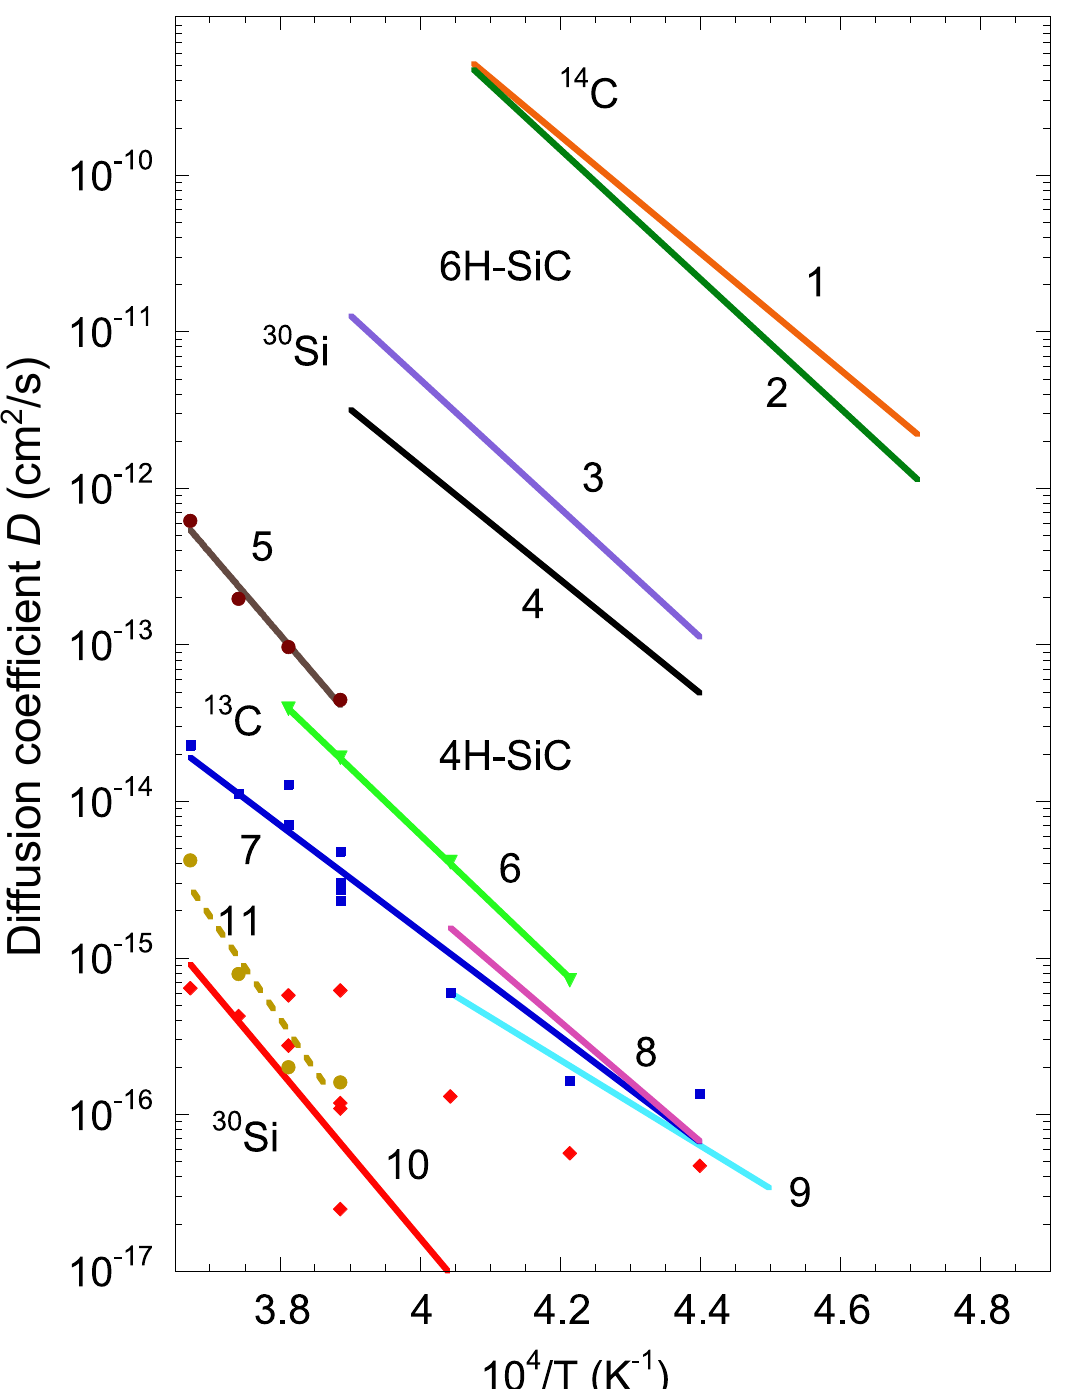
Figure 4. Arrhenius behavior of Si and C diffusivities fitted according to Equation (2), from both this work and the literature. Numbers refer to the present work (No. 5 for 13 C and No. 11 for 30 Si) and Refs. [2,5,6,28,29] (No. 1–4 and No. 6–10), with additional specifiers for the numbering collected in Table 3. Note that results in the same color are related. For example, the dark brown data points and fit refer to 13 C, while the light brown ones refer to 30 Si, both from the present